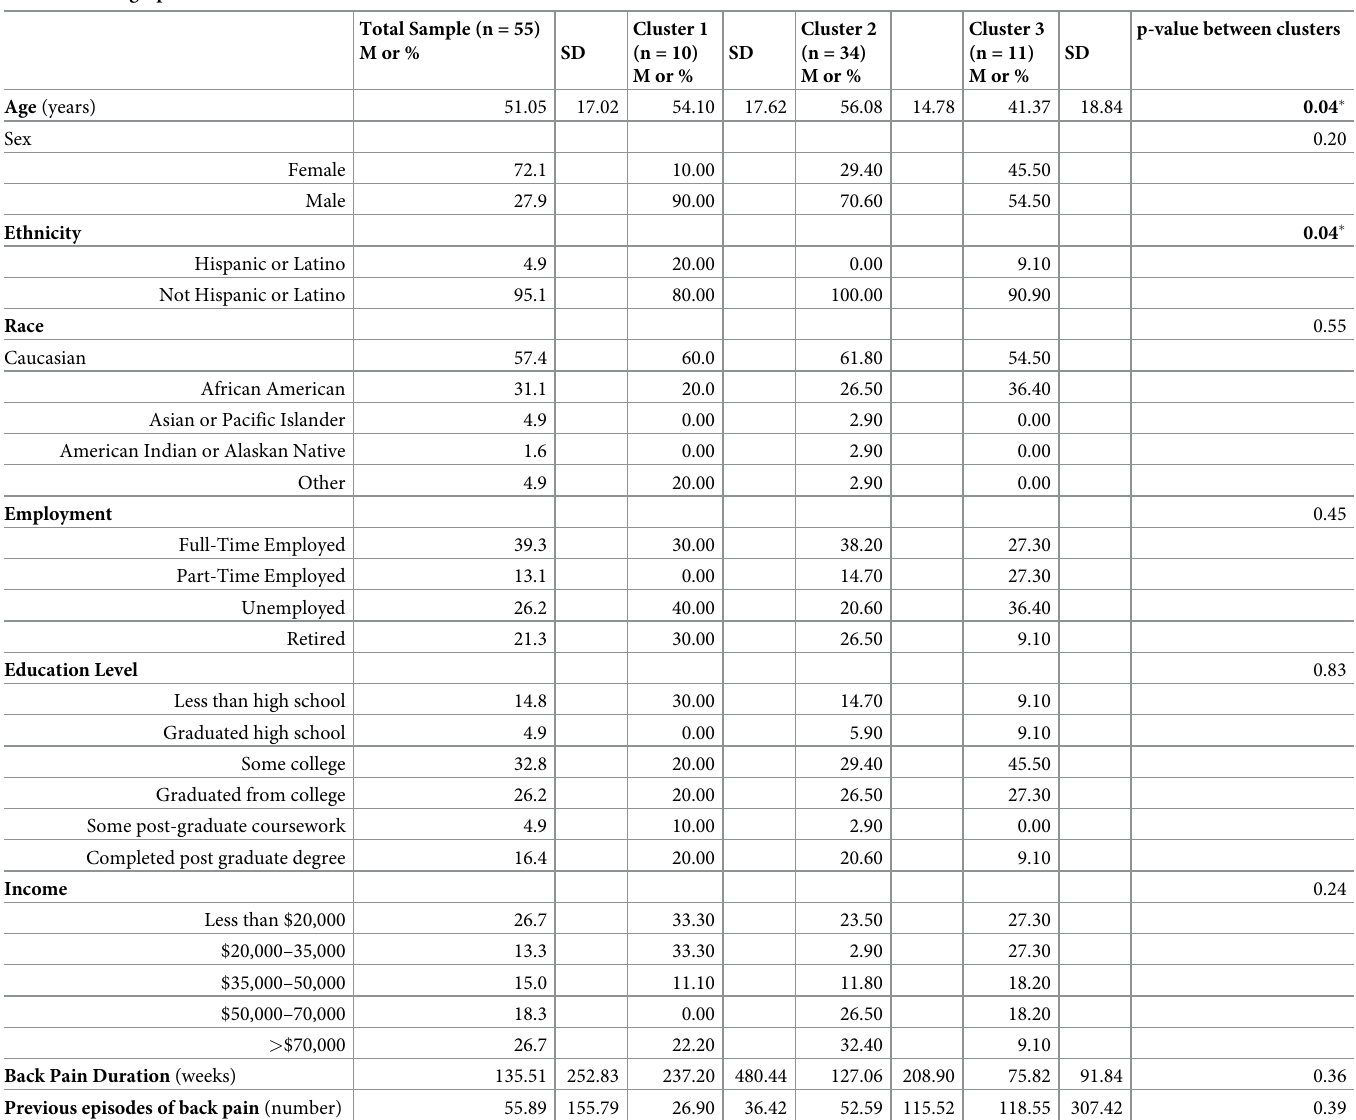
Table 1. Demographic and clinical factors.